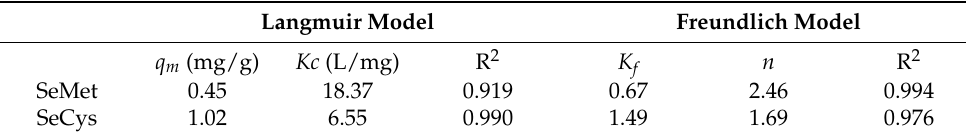
Table 3. Adsorption isotherm parameters for organoselenium removal.